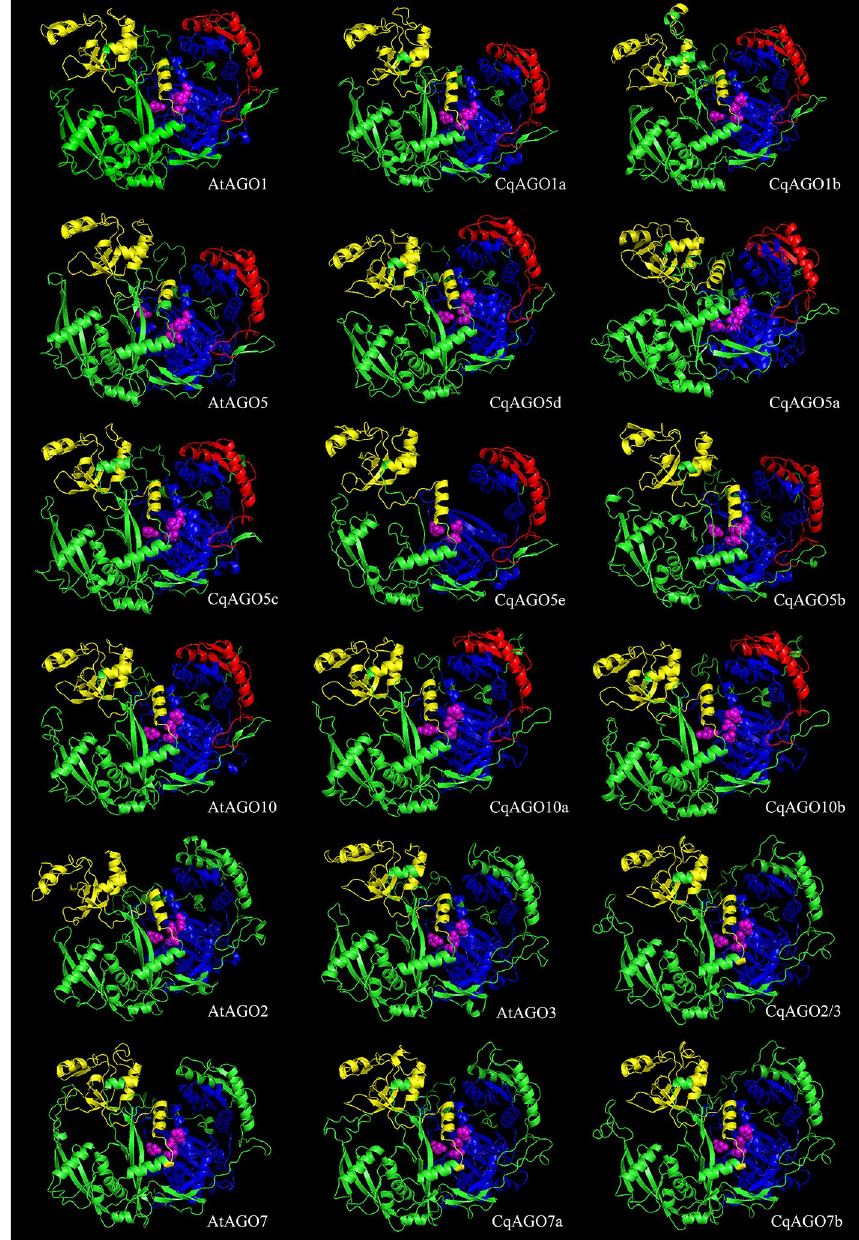
Figure 7. 3D structure predictions for the AtAGO1/5/10 and AtAGO2/3/7 clades, as predicted using SWISS- MODEL. PAZ (yellow), PIWI (blue), and MID (red) domains as predicted using SMART and Pfam are displayed. DEDD/H is marked by magenta